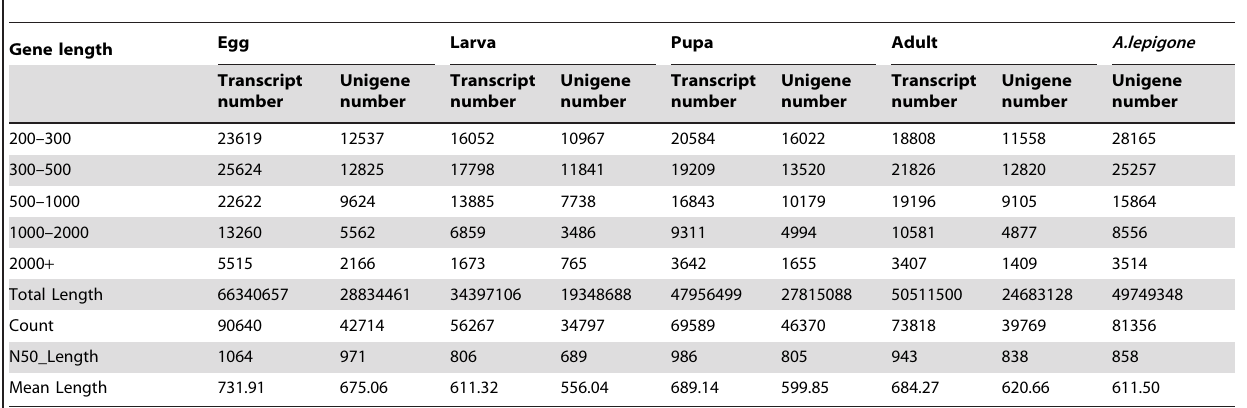
Table 2. Summary for A. lepigone transcriptome.